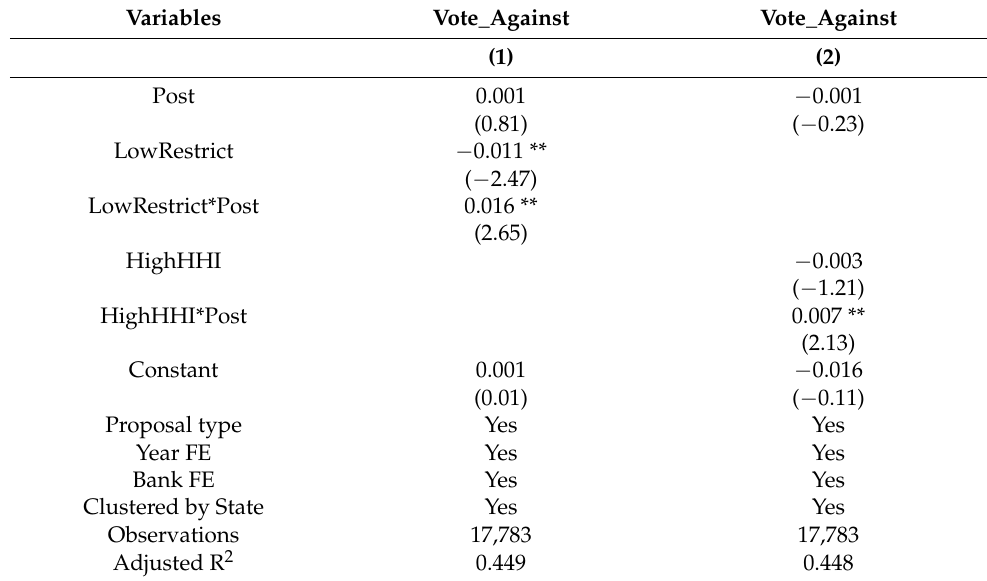
Table 3. Deregulation degree and pre-deregulation competition